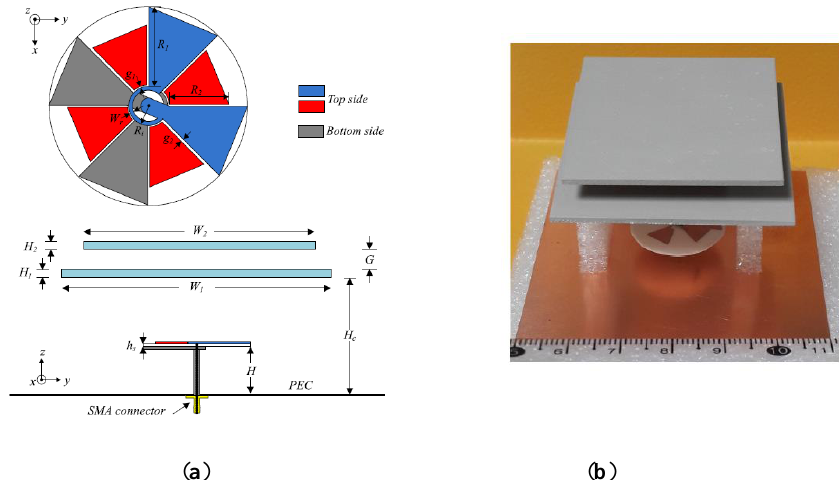
Figure 3. Configuration of a wideband RCA with a PRS of sharp resonance: ( a ) Entire geometry; ( b ) Fabricated structure [67].